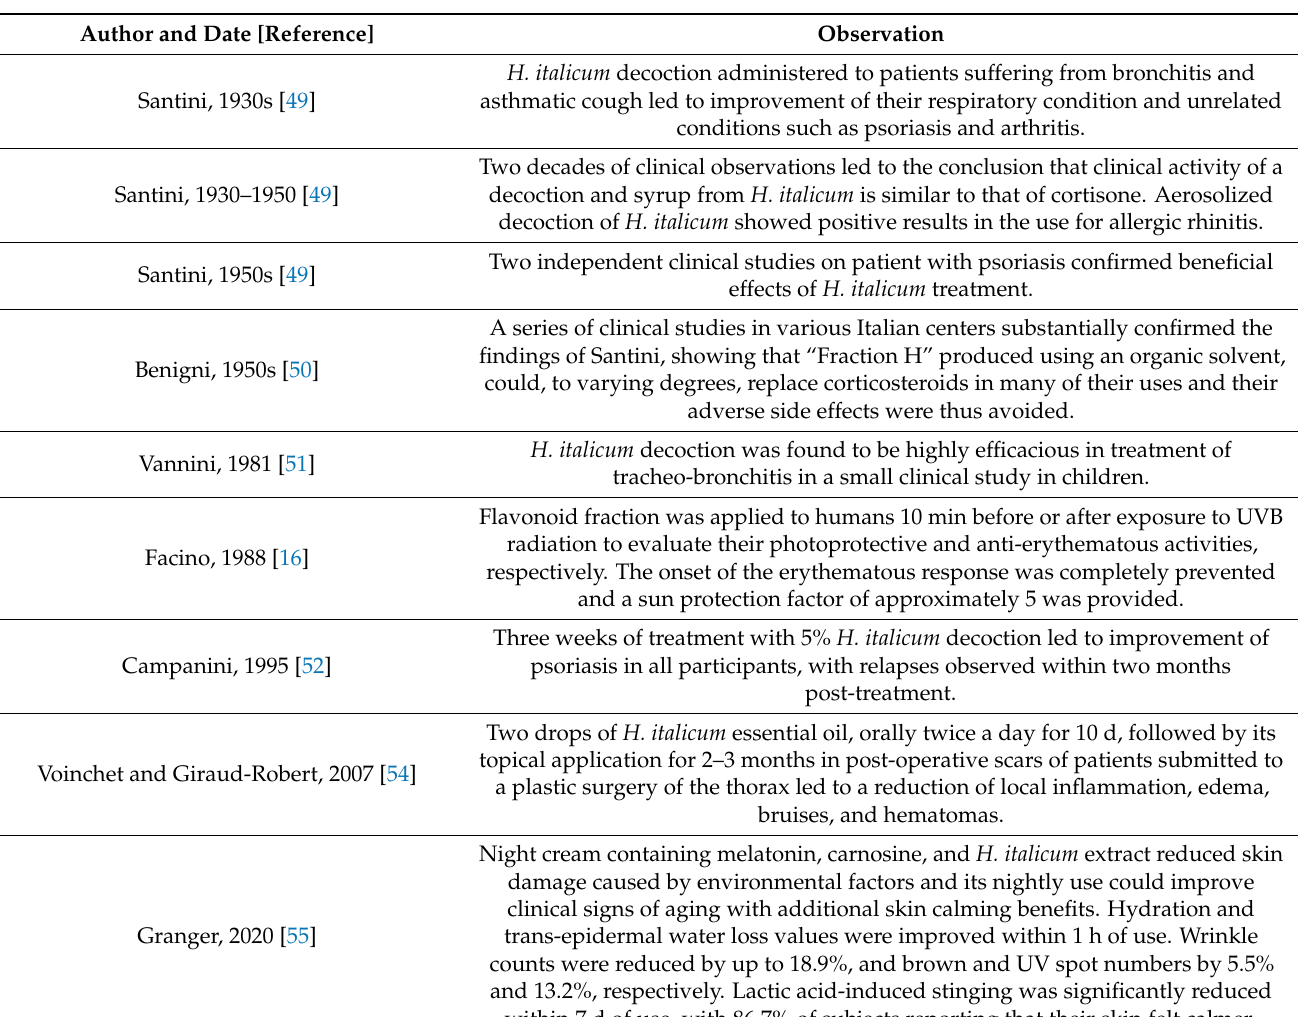
Table 2. Clinical observations in humans, listed in chronological